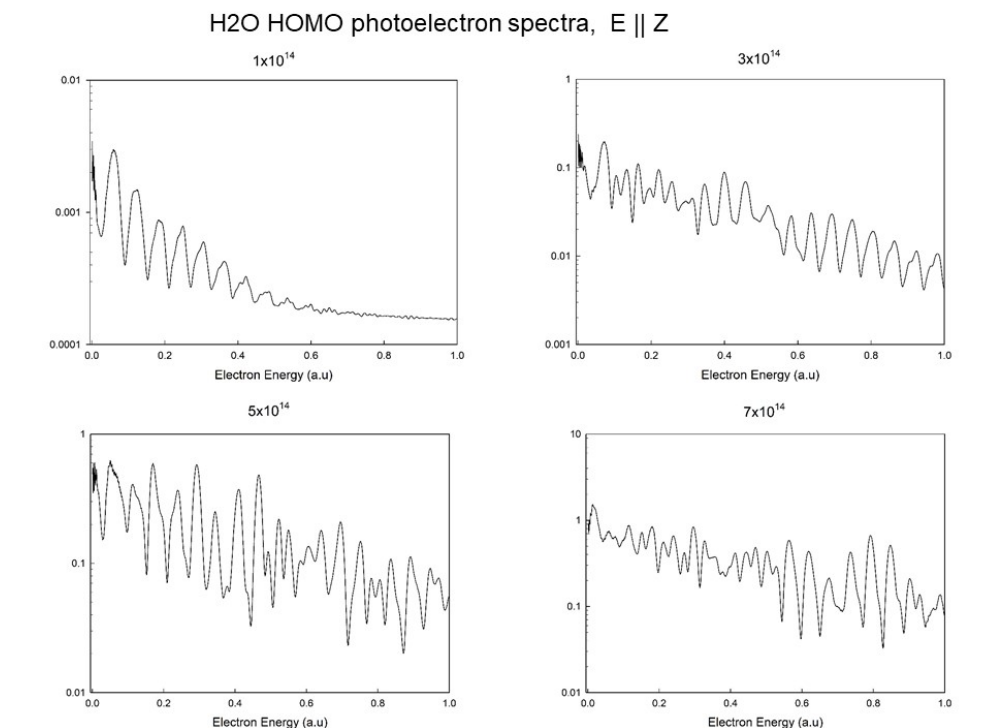
Figure 9. Photoelectron spectrum (ionization probability) relative to HOMO ionization in water at I = 1.0 × 10 14 , 3.0 × 10 14 , 5.0 × 10 14 and 7.0 × 10 14 (blue) W/cm 2